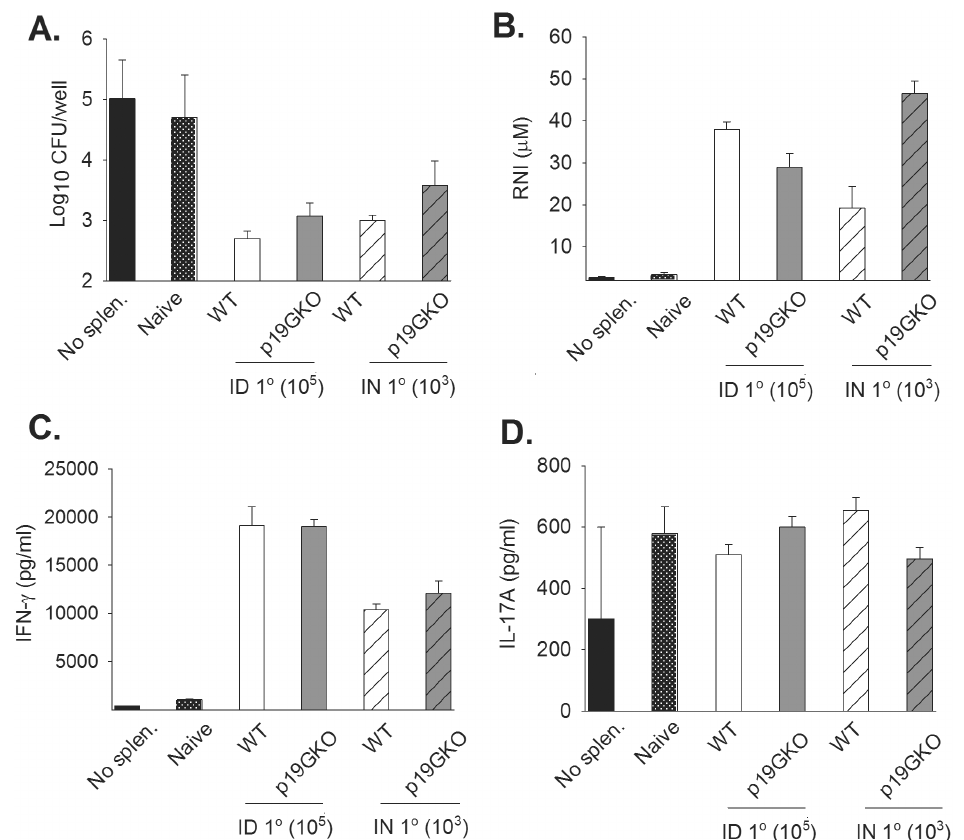
Figure 4. T cell functions and cytokine production are similar between WT mice and p19G KO mice, regardless of priming route. WT mice and p19G KO mice were infected with 10 5 LVS ID or 10 3 LVS IN. Mice were sacrificed after 8 weeks and splenocytes isolated; splenocytes were also obtained from naı¨ve mice. Bone marrow-derived macrophages from WT mice (shown) or p19G KO mice (not shown) were infected with LVS, and then 5 6 10 6 homologous splenocytes were added to triplicate wells of infected macrophages. A) Intracellular bacterial burdens were assessed immediately after infection at 0 hours (not shown) and at 72 hours after infection. B) Supernatants were harvested from cultures at 72 hours after infection, and the levels of RNI measured. Supernatants were also assayed for cytokines by sandwich ELISA, including C) IFN- c and D) IL-17A. IL-12p40 and IL-12p70 were also measured (data not shown). Results are shown for one representative experiment of three experiments of similar design and outcome. *p value # 0.05 by Student’s t test.